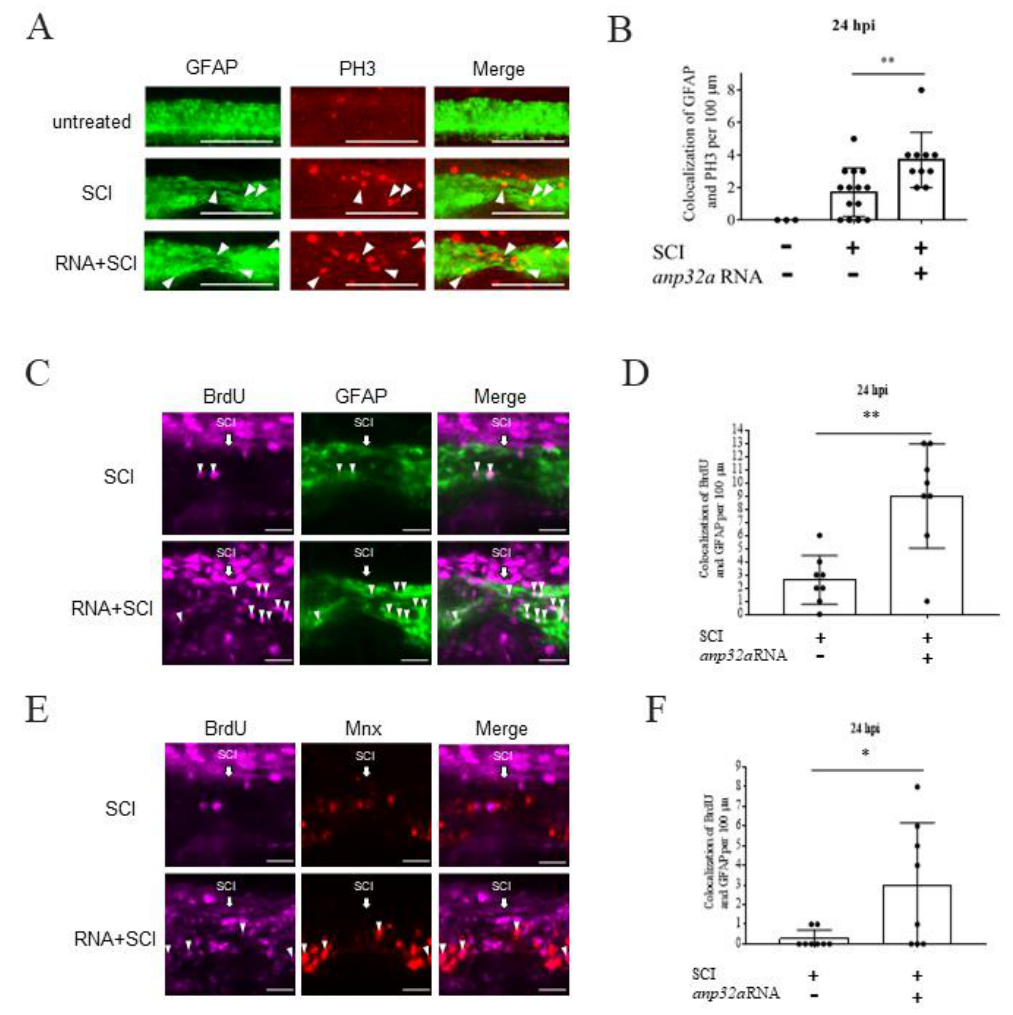
Figure 8. Proliferation and cell number of radial glial cells and motor neurons were increased in the Anp32a -overexpression SCI embryos. The Anp32a mRNA was microinjected into the one-cell stage of embryos from zebrafish transgenic lines ( A , B ) Tg(gfap:GFP) and ( C – F ) the crossed strain of Tg(gfap:GFP) and Tg(mnx1:TagRFP) , followed by BrdU injection, SCI at 48 hpf, and finally, staining with PH3 at 24 hpi. ( A ) Proliferation patterns at the lesion site of Tg(gfap:GFP) embryos treated as indicated at 24 hpi were displayed by immunofluorescence through reaction with antibodies against phosphorylated histone H3 (PH3; Red) and observation under laser confocal microscopy. ( B ) Statistical analysis showed a significantly increased number of PH3-positive cells in Anp32a -overexpressed SCI embryos ( n = 10) compared to untreated embryos ( n = 3) and SCI-control embryos ( n = 14) at 24 hpi. One-way ANOVA followed by Tukey’s multiple comparison test was used to perform statistical analysis (*, p < 0.05; ** p < 0.01; error bars indicate mean ± SD). ( C ) Proliferation patterns at the lesion site of transgenic cross strain Tg(gfap:GFP) X Tg(mnx1:TagRFP) embryos treated as indicated at 24 hpi showing GFAP-positive cells (green) colocalized with BrdU-positive cells (purple) around the lesion area. ( D ) Statistical analysis of GFAP +/BrdU+ colocalized cells in SCI-control and Anp32a -overexpressing SCI embryos. ( E ) Proliferation patterns at the lesion site of Tg(gfap:GFP) X Tg(mnx1:TagRFP) embryos treated as indicated at 24 hpi showing red-labelled motor neurons colocalized with BrdU-positive cells (purple) around the lesion area. The specimens in Figure 8C, F originated from the same embryos. ( F ) Statistical analysis of motor neuron +/BrdU + colocalized cells in SCI-control and Anp32a -overexpression SCI embryos. Scale bar: 100 µ m; ( D , F ) Student’s t -test was used to perform statistical analysis (* p < 0.05; ** p < 0.01; error bars indicate mean ±